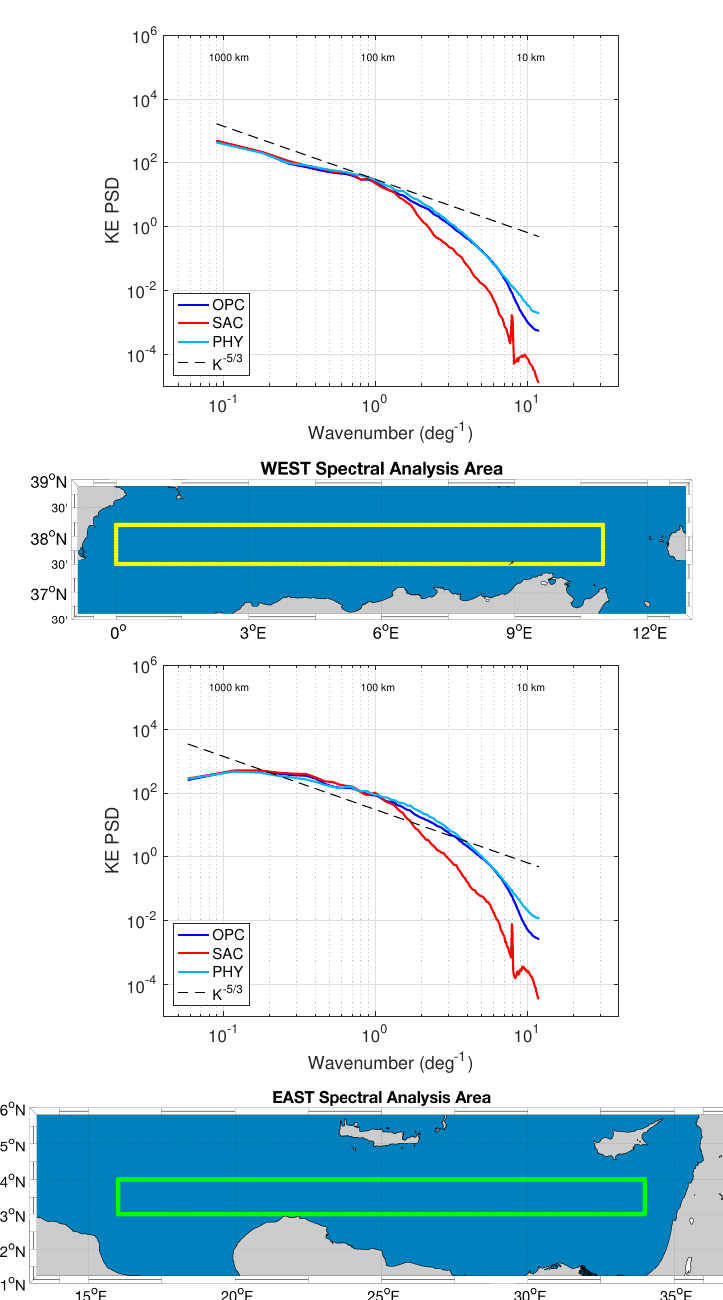
Figure 11. Kinetic energy power spectral density of the Synthetic Altimeter Currents (SAC, red), OPtimal currents (OPC, blue) and CMEMS PHY modelled currents (light blue). The spectra are computed in the WEST and EAST areas of the Mediterranean, depicted by the yellow and green borders,